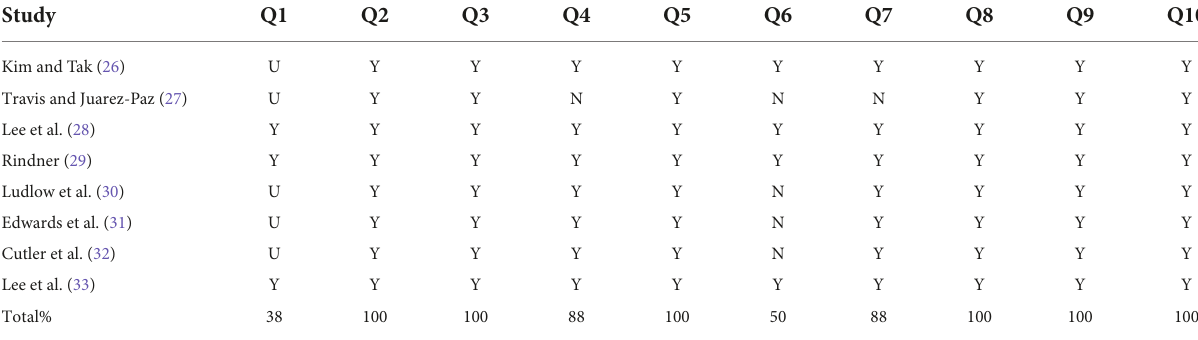
TABLE 3 Quality assessment of the included studies.